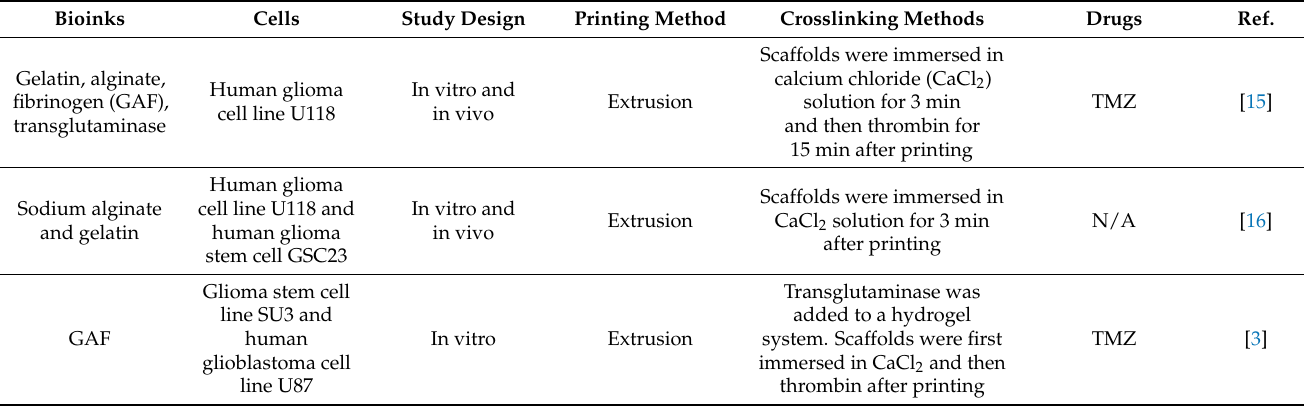
Table 2. Characteristics of the included studies ( n =